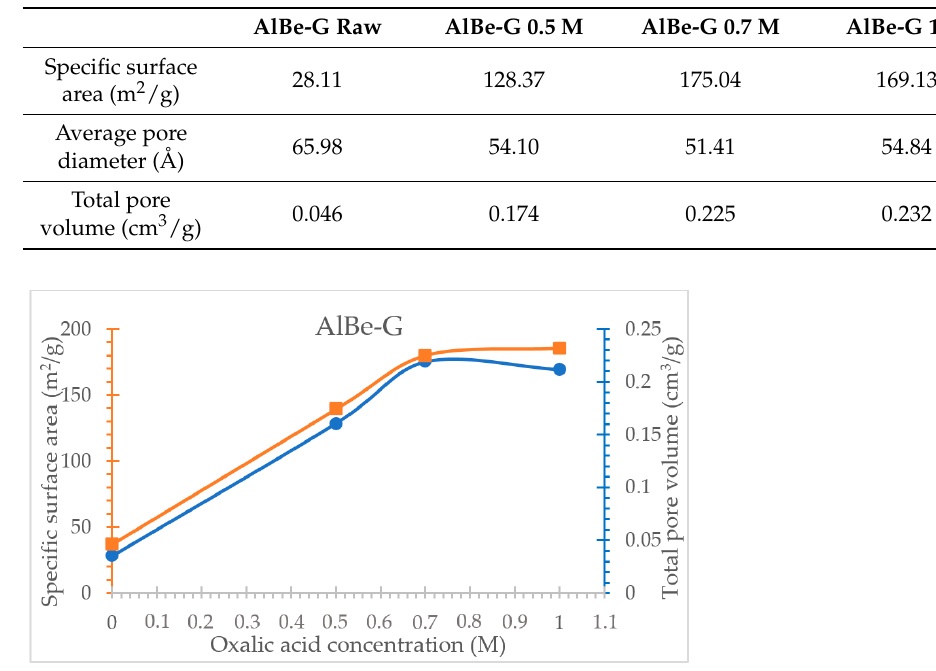
Table 2. Specific surface area and porosity of raw and treated AlBe-G bentonite (80 ◦ C; acid concen- trations of 0.5 M, 0.7 M and 1 M; 2% of pulp density).